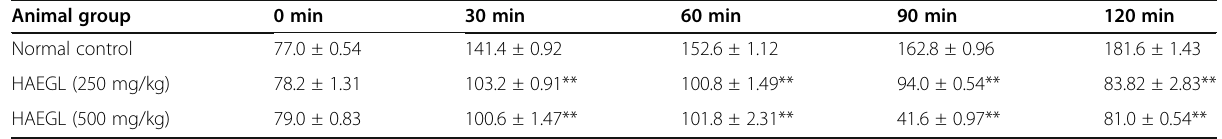
Table 3 Effect of HAEGL on oral glucose tolerance test in Wistar albino rats Animal group